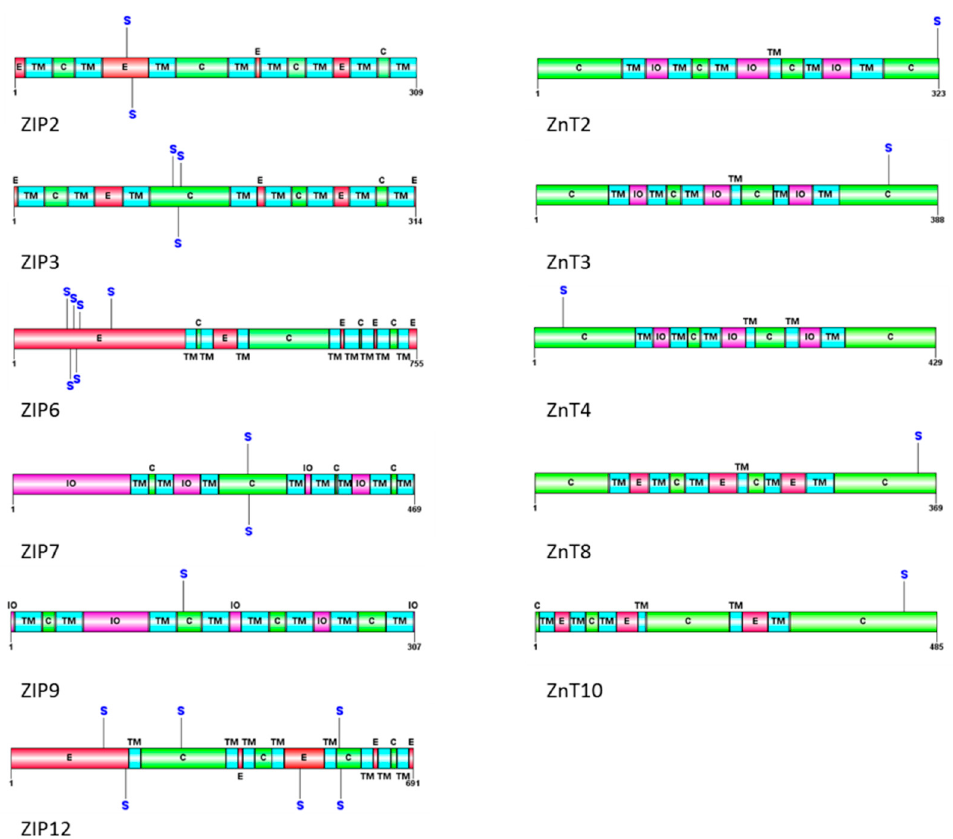
Figure 1. Schematic view of the phosphorylation sites in ZIP and ZnT channels predicted to be phosphorylated by CK2. CK2 phosphorylation sites were predicted using GPS 3.0 software. Transmembrane domains are identified according to Uniprot (http://www.uniprot.org) and the original publications for ZIP2 [84], ZIP3 [84], ZIP6 [84,85], ZIP7 [84,85], ZIP9, ZIP12 [86]. The six TM domains of ZnT2, 3, 4, 8 and 10 are based on an atomic-resolution structure of YiiP [87,88]. TM denotes transmembrane (blue), E for extracellular (red), C for cytoplasmic (green), IO for intra-organellar, S for serine.